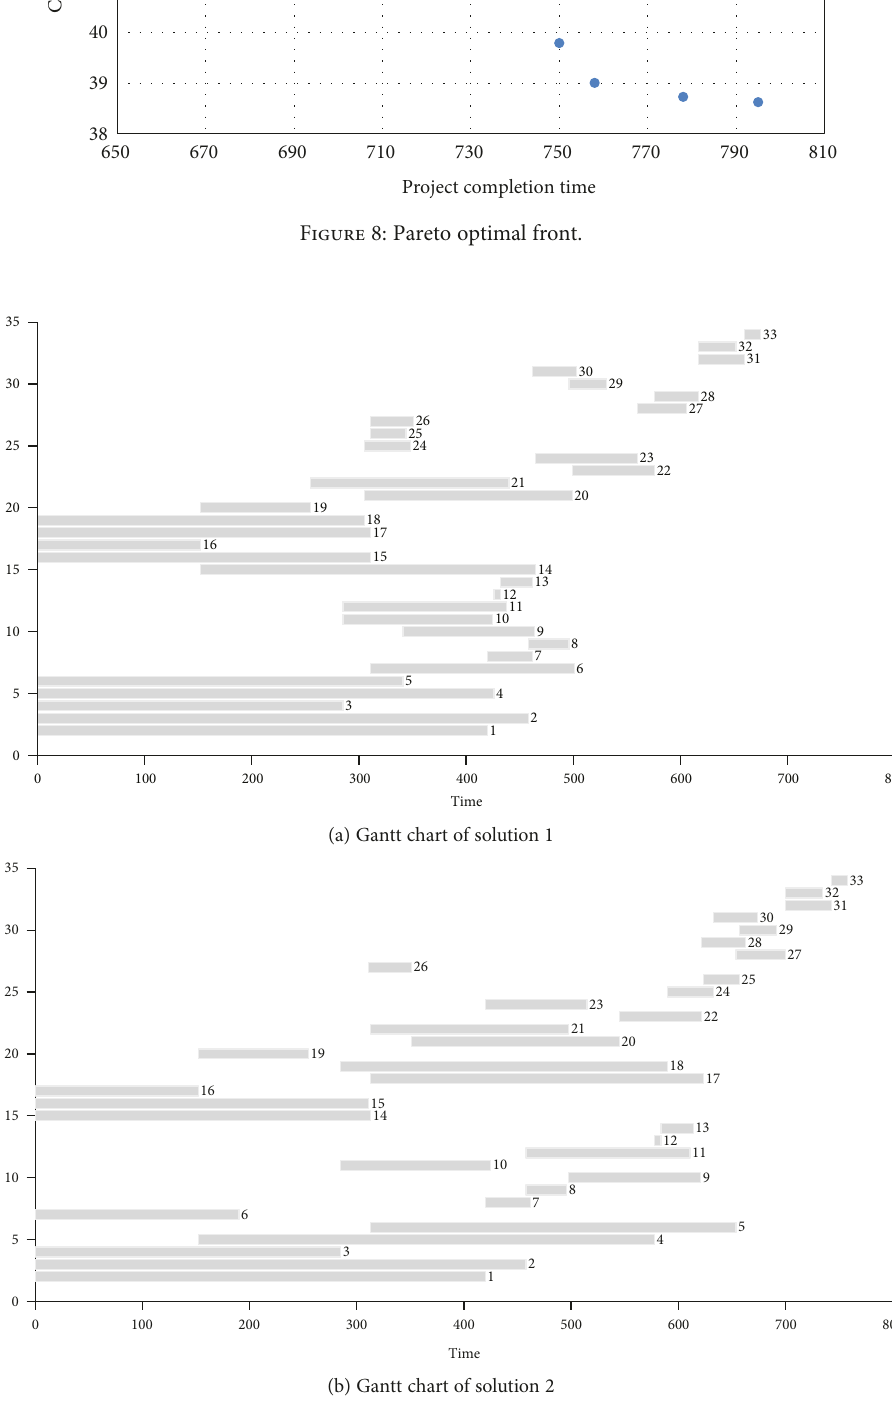
Figure 9: Gantt chart of solution 1 and solution